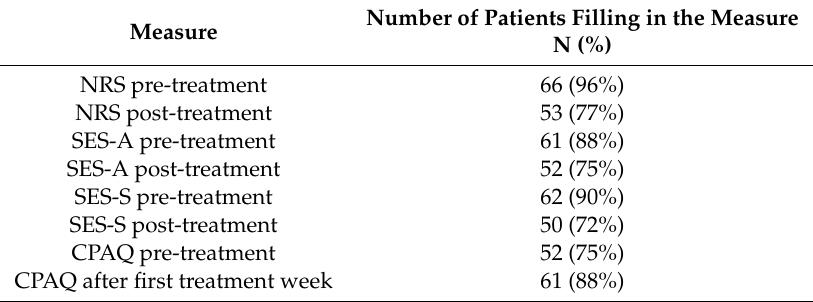
Table 1. Number of patients filling in the questionnaires. N = 69.